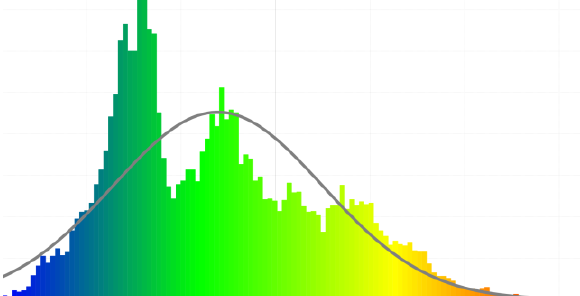
Figure 7 Misalignment graph between knowledge-based